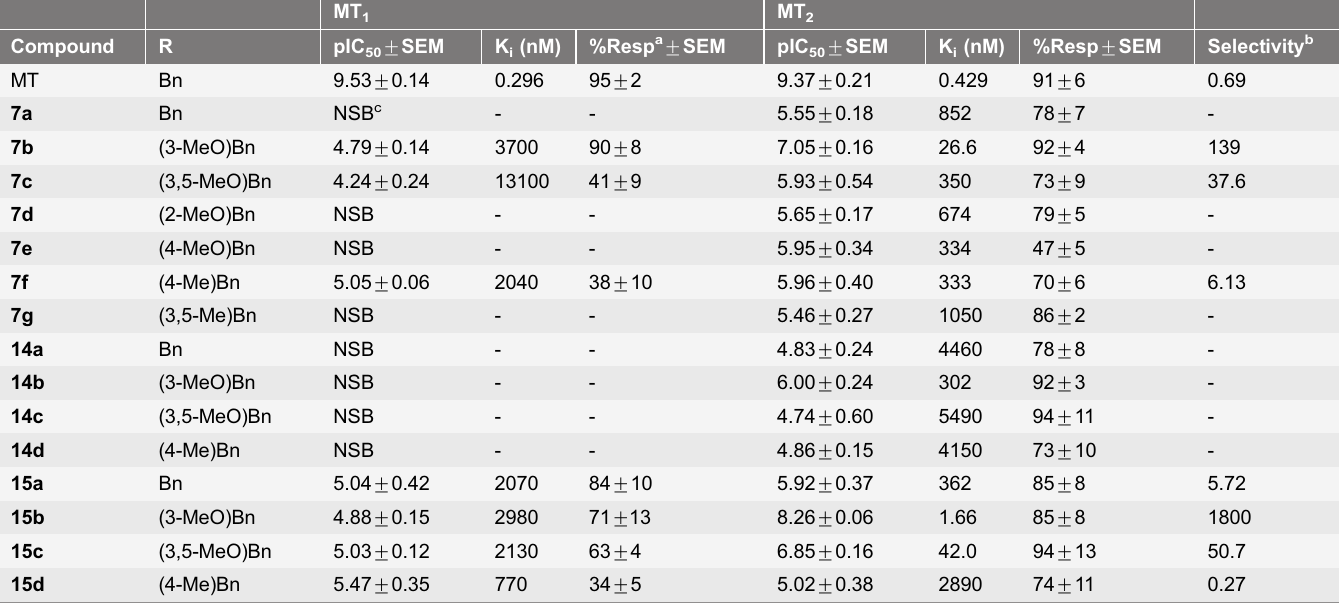
Table 1. Binding affinities of the tested compounds towards human MT 1 and MT 2 expressed in CHO cells. MT 1 MT